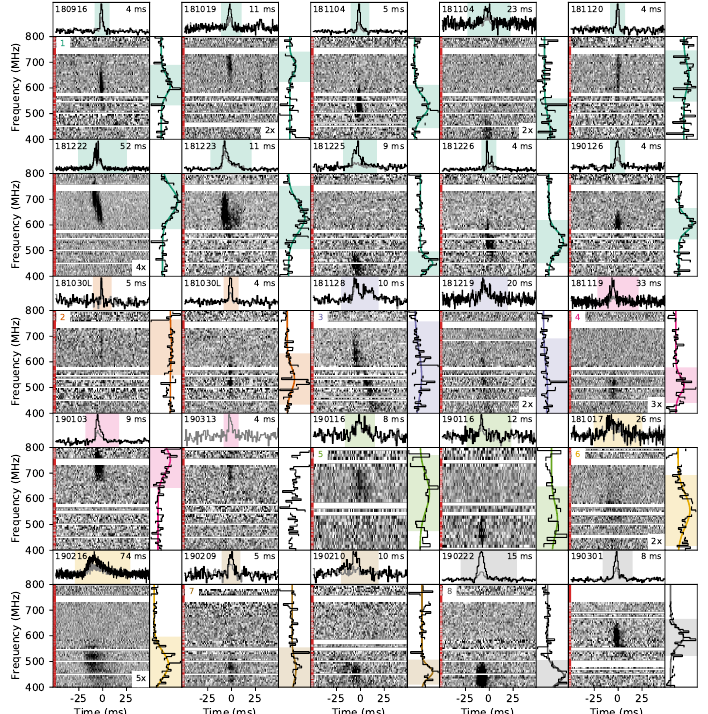
Figure 6. Figure 3 from [56] “CHIME/FRB Discovery of Eight New Repeating Fast Radio Burst Sources” reproduced with permission from Emmanuel Fonseca, published by ApJL (IOP Publishing), 2019. Profiles, dynamic spectra and spectral distributions are shown for eight new repeaters discov- ered by CHIME. The color coding separates bursts from different sources. FRB20180916B, in green, was the first source in this work, showing its prolific activity compared to the other